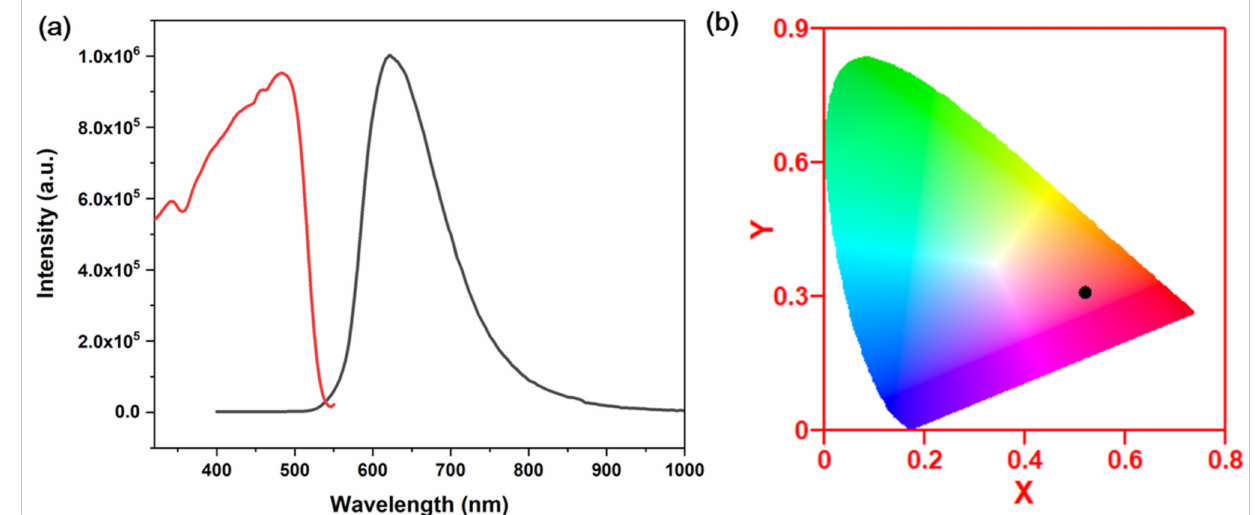
Figure 4. ( a ) Excitation (red curve) and emission spectrum (black curve) of 1 . λ ex = 360 nm, λ em = 620 nm. ( b ) CIE coordinates of compound 1